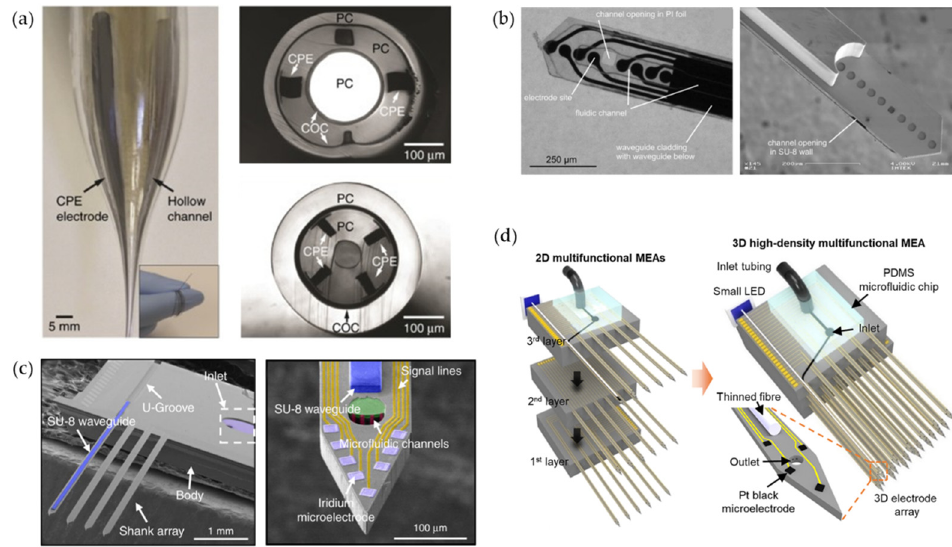
Figure 2. Different kinds of multifunctional optoprobes integrating optical stimulation, electrical recording, and microfluidic channels. ( a ) Multifunctional coaxial polymer fiber-based optoprobe achieved by thermal drawing process. Refractive index difference between medical-grade materials- polycarbonate (PC) and cyclic olefin copolymer (COC) allow light to be confined within PC, while the polymer composite-conductive polyethylene (CPE) is used as recording electrode [94]. ( b ) Micrographs of two multifunctional optoprobes with different waveguide output surfaces (flat, concave) which might influence the light propagation in tissue [95]. ( c ) View of the multifunctional MEMS two-dimensional multi-handle waveguide-based optoprobes. Reprinted under a Creative Commons Attribution (CC BY) license [96]. ( d ) Schematic illustrations showing three 2D multifunctional optoprobes before stacking and bonding (left), assembled 3D high-density multifunctional array (middle) [97]. Reprinted under a Creative Commons Attribution (CC BY) license.